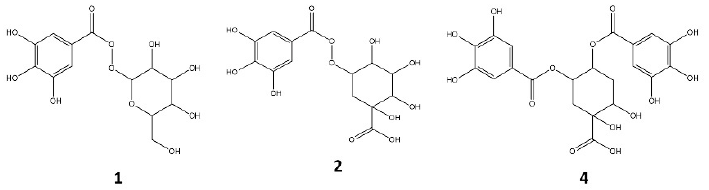
Figure 3. Structure of the main galloyl acid derivatives identified in A. chilensis leaf extracts.